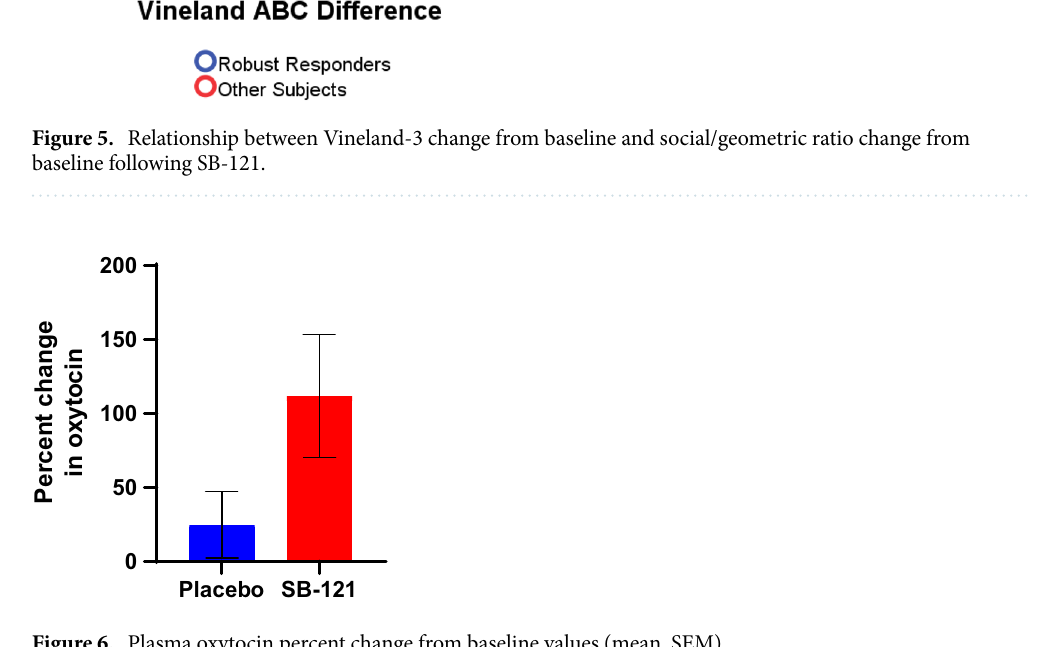
Figure 6. Plasma oxytocin percent change from baseline values (mean,